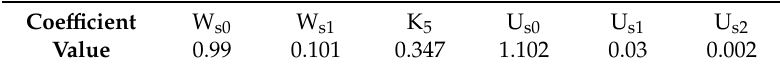
Table 7. Coe ffi cients for Objective Functions 5 and